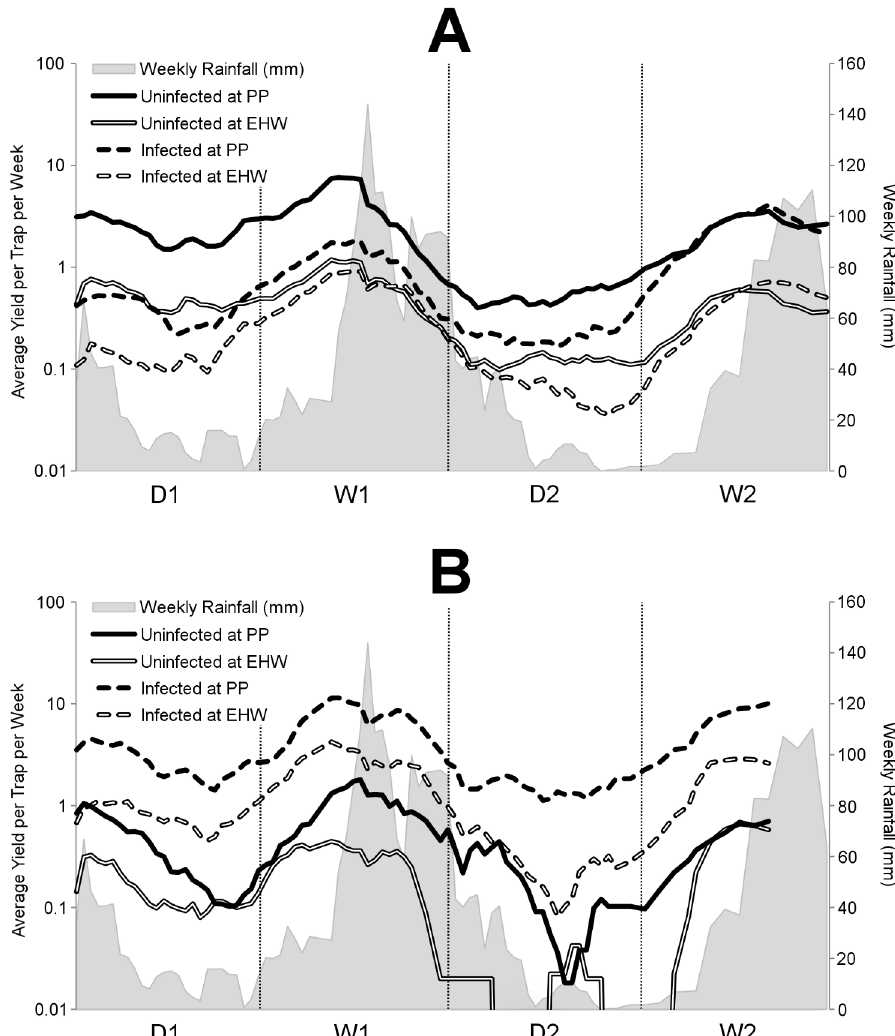
Fig 2. Average trap captures for infected and uninfected Ae . aegypti . Ae . aegypti caught offsite (A) and onsite (B) are graphedatop weeklyCairns rainfall. Yields and rainfallare smoothedusing a moving averageof the 5 most recent observations. Trap yields are plotted on a logarithmic scale to show comparative rates of change.After accountingfor the seasonaltrend in abundances, uninfectedmosquitoyields offsite (A) decreased over time at both Parramatta Park (PP) and Edge Hill/Whitfield (EHW). Offsite yields of infected mosquitoesincreasedat PP towards the end of the study but remained relatively constant at EHW. Onsite (B) yields of infected mosquitoesremained relatively constant at EHW and PP, while uninfectedmosquitoyields decreased heavilyin the second dry season (D2) but recovered in the followingseason.